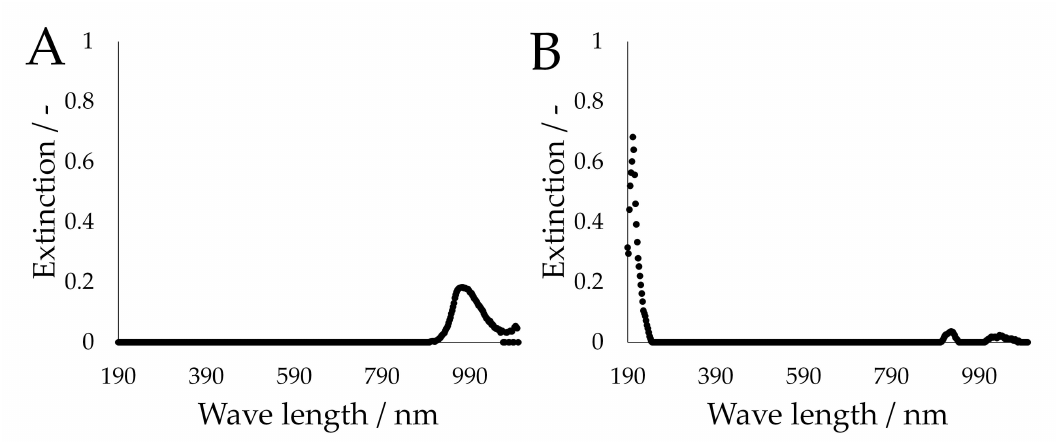
Figure A1. Ultraviolet–visible light (UV–Vis) spectra of water ( A ) and 1-hexanol ( B ). Reference medium: